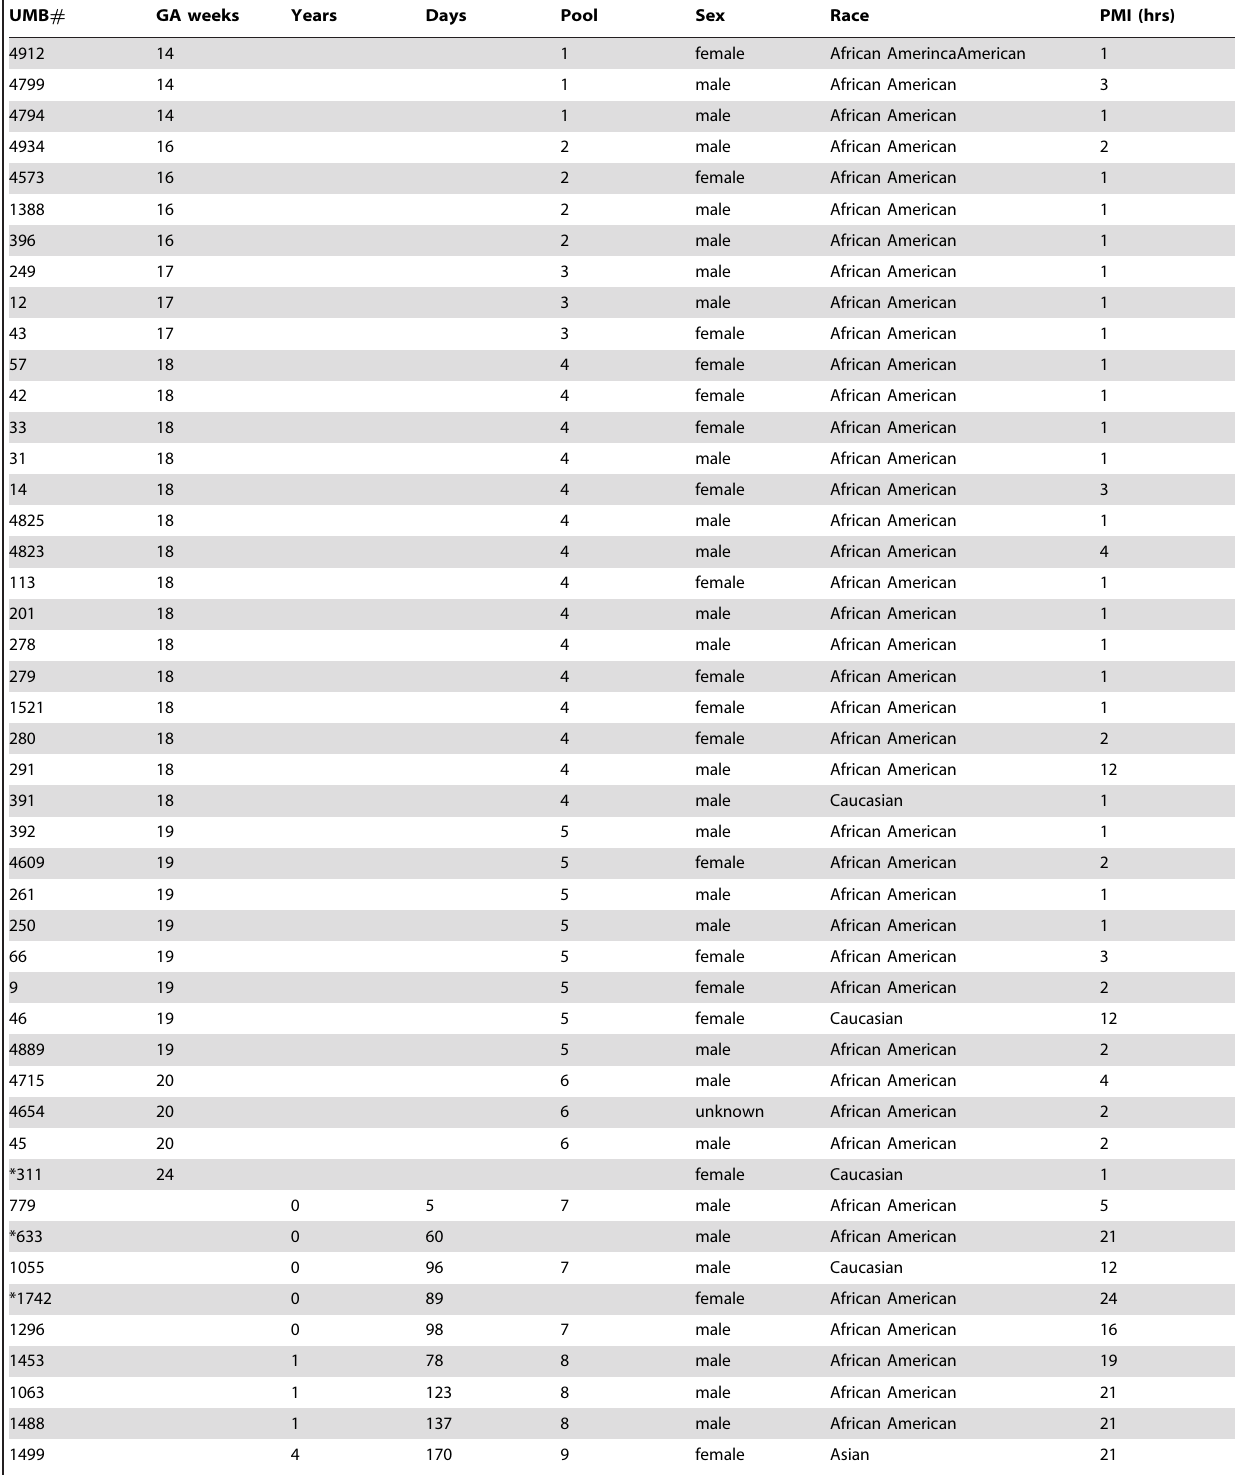
Table 1. Demographic information of brain tissue